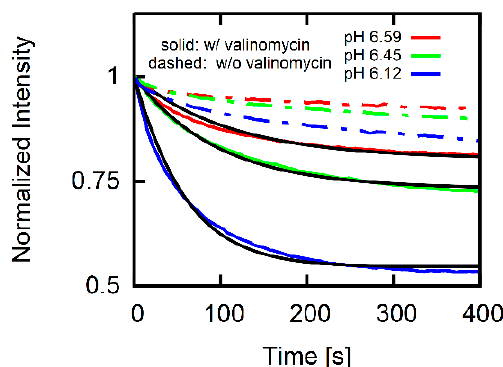
Figure 3. Assessment of membrane proton permeability. DOPC vesicles in 100 mM KCl, 2 mM MES, pH 7 (inside additionally 0.5 mM CF) are exposed to decreased external pH (denoted in the key) by addition of HCl. The potassium ionophore valinomycin (final concentration 1 µ M) clamps the transmembrane potential to almost zero (solid colored lines). A global fit of I theor (black lines) to I exp (colored lines) reveals a proton permeability of P H + = 3.5 · 10 − 5 cm/s in the presence (w/) of valinomycin. The kinetics are slower in the absence (w/o) of valinomycin (dashed lines) confirming that membrane potential U > 0 mV hinders proton translocation across the membrane.